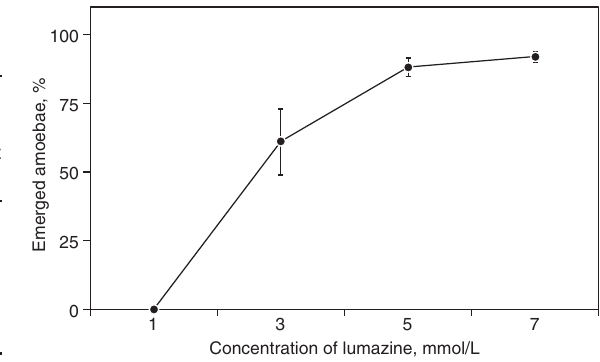
Figure 3 Estimation of the fluorescent substances as lumazine equivalent in the spore mass. The fluorescent substance concen- tration (in lumazine equivalent) in the spore mass was estimated based on the percent of emerged amoebae after spores were UV-C irradiated (1440 J/m 2 ) in indicated concentrations of lumazine solution. Lumazine solution (1, 3, 5, and 7 mmol/L) was used for the experiment. Data points represent the mean values of two or three experiments with standard deviations. The mean at 3 mmol/L of lumazine shows a significant difference from those at 5 and 7 mmol/L of lumazine (p < 0.05; Sheffe’s